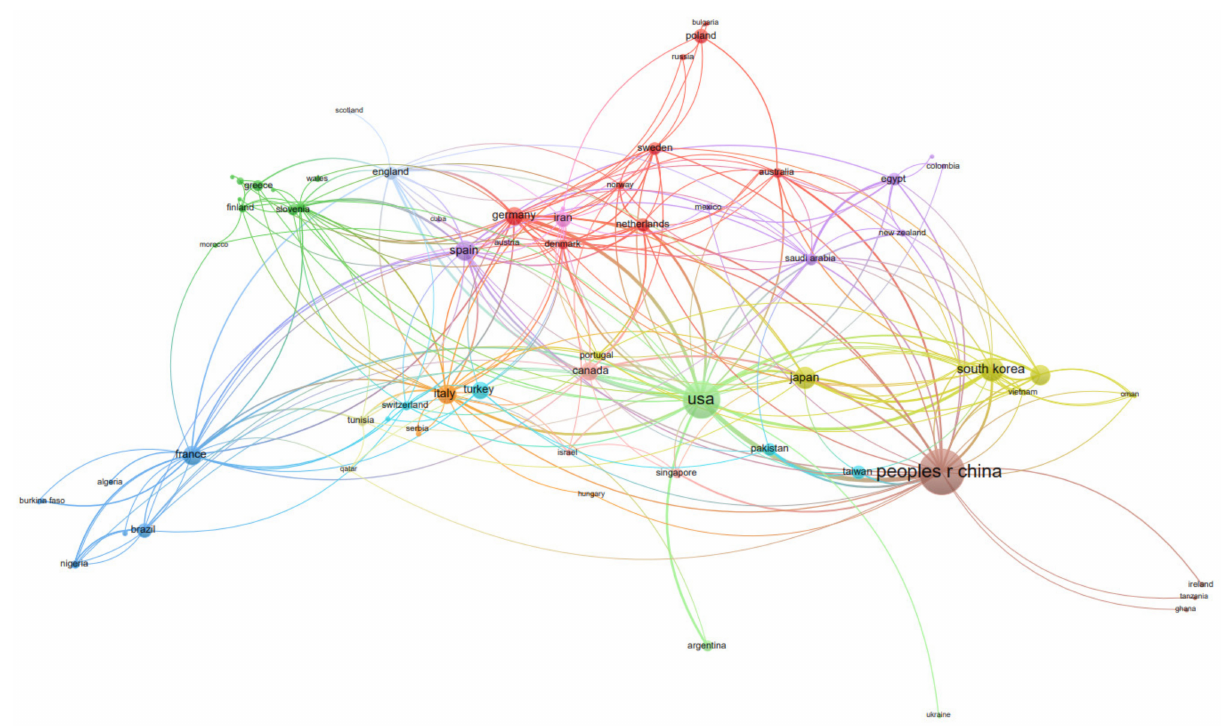
Figure 3. Country distribution of “BPA toxicity” literature according to co-authorship analysis.